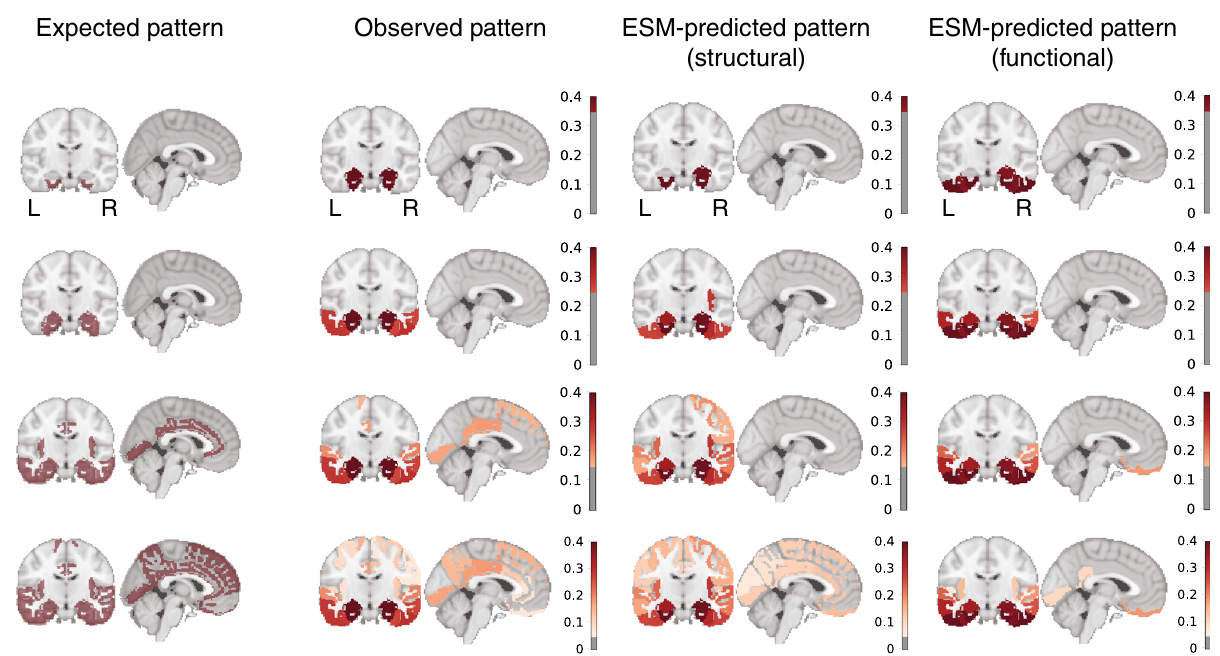
Fig. 4 Hypothesized, observed, and predicted pattern of tau spreading. (Left) Hypothetical spread patterns represented by Braak stages I, II, VI, V, and VI as described in ref. 83 . (Right) Spreading patterns of (from left to right) the observed tau-PET data, the ESM simulated data using a young structural connectome, and using a young functional connectome. Warmer colors represent higher proportion of regional tau-positivity predicted or observed across the population. Each “ stage ” was achieved by arbitrarily thresholding the population-mean tau-positive probability image at the following thresholds: 0.35, 0.25, 0.15, and 0.05.